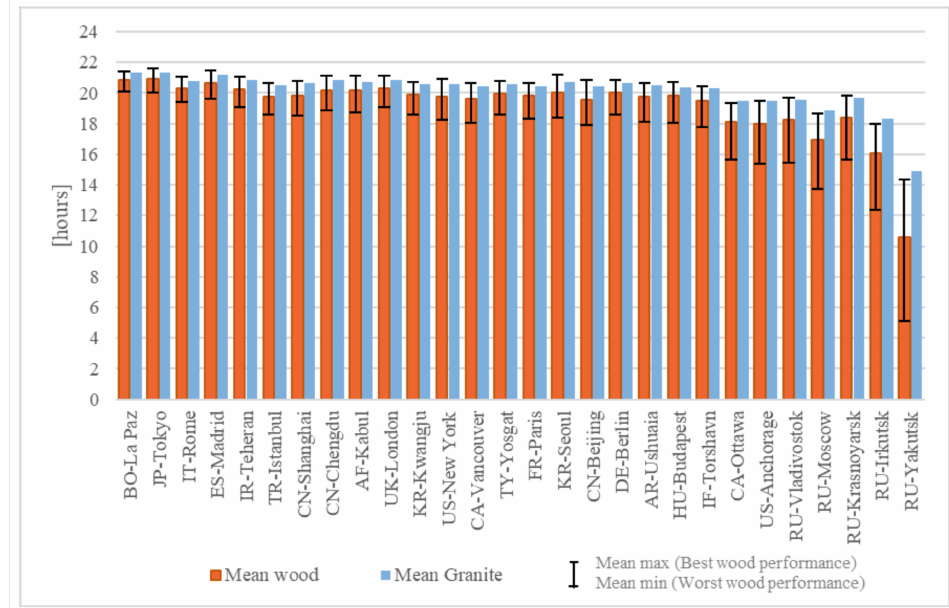
Figure 5. Mean values of comfort hours in each city.